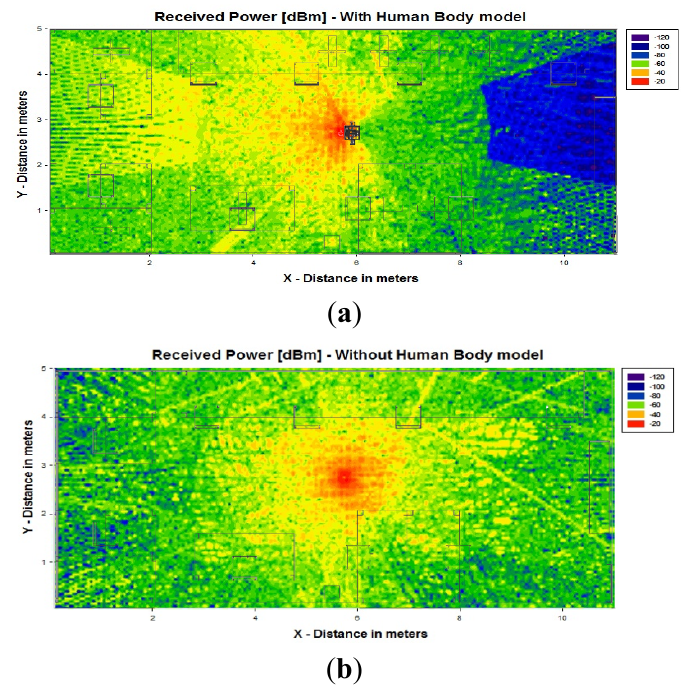
Figure 7. Spatial distribution of Received Power [dBm] for 1.30 meters height in the indoor scenario with ( a ) the presence of a human body model in the center ( b ) without the human body